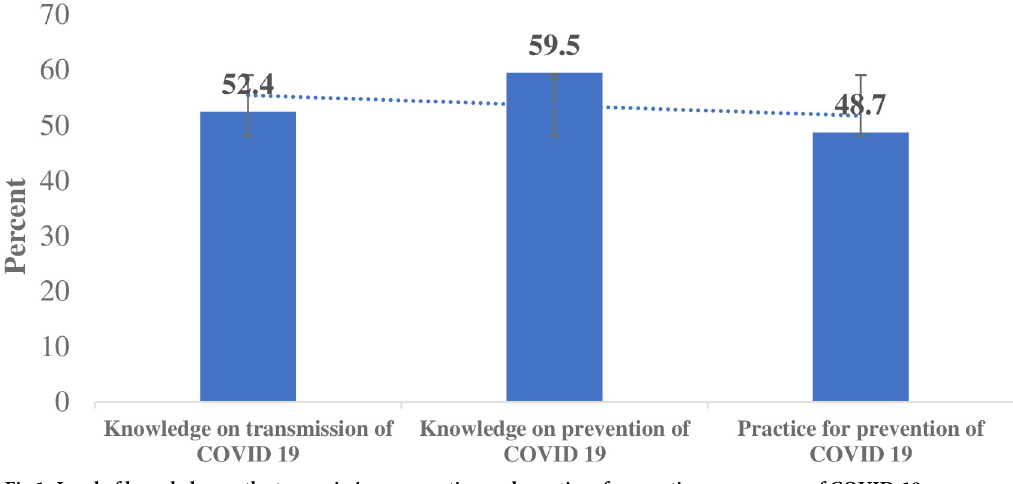
Fig 1. Level of knowledge on the transmission, prevention and practice of precautionary measure of COVID-19.